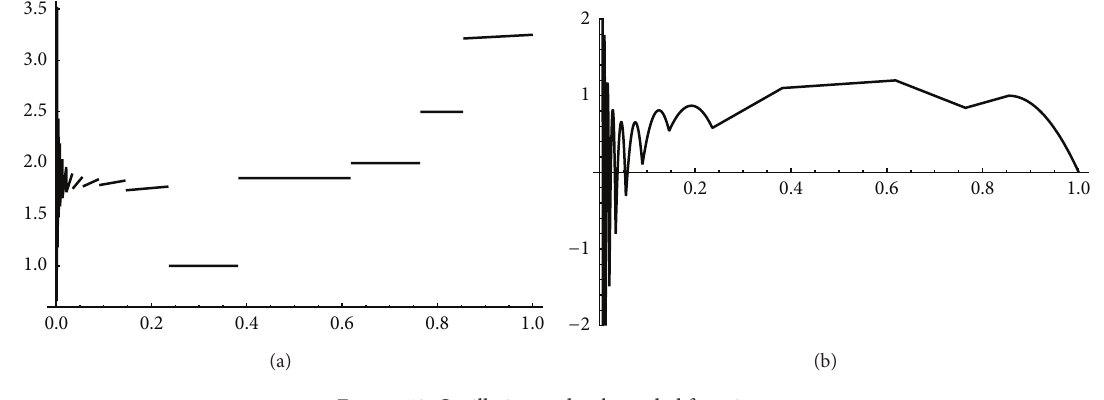
Figure 12: Oscillating and unbounded functions.